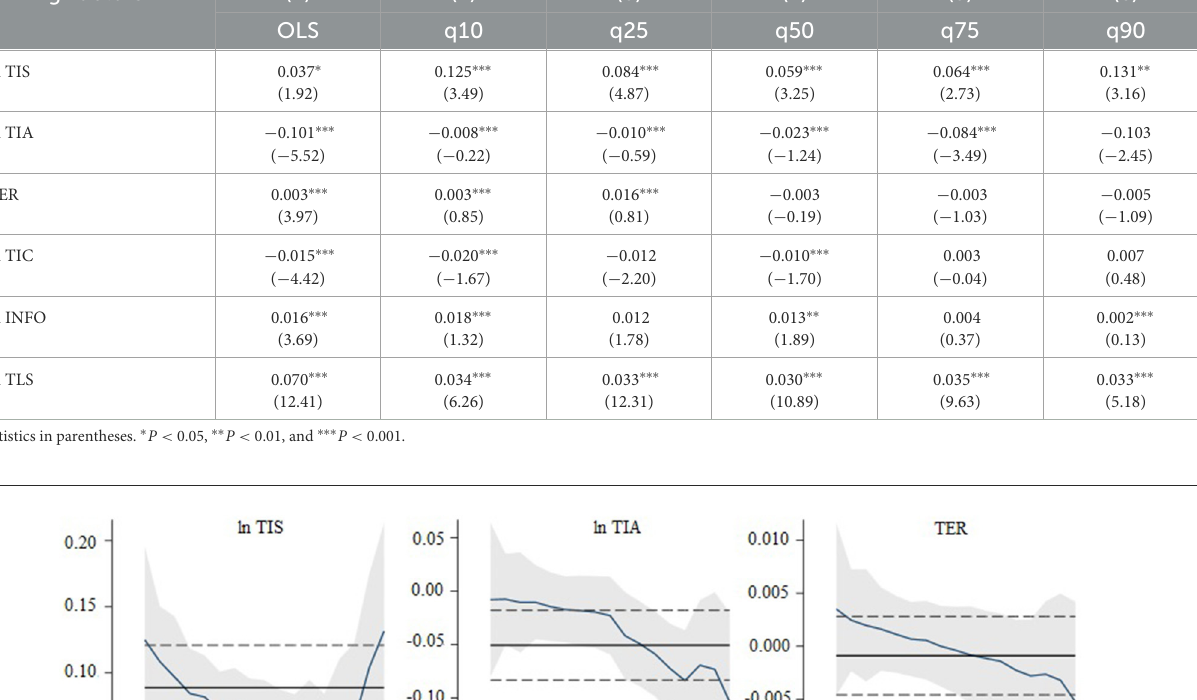
TABLE 7 The quantile regression model estimation results of driving factors of tourism ecosystem health. Driving Factors